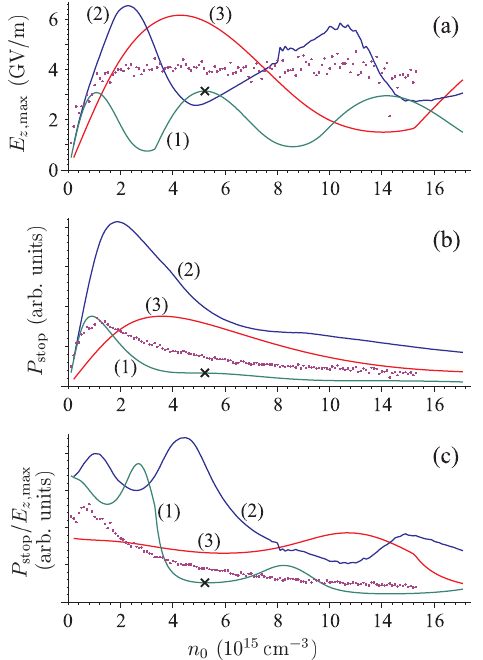
FIG. 2. (Color) Density dependence of the maximum on-axis electric field (a), stopping power of the driver (b), and ratio of the two (c) for fixed-shape beams (solid lines) and for the equilib- rium beam (dots). The crosses show the ‘‘linear optimum’’ plasma density.